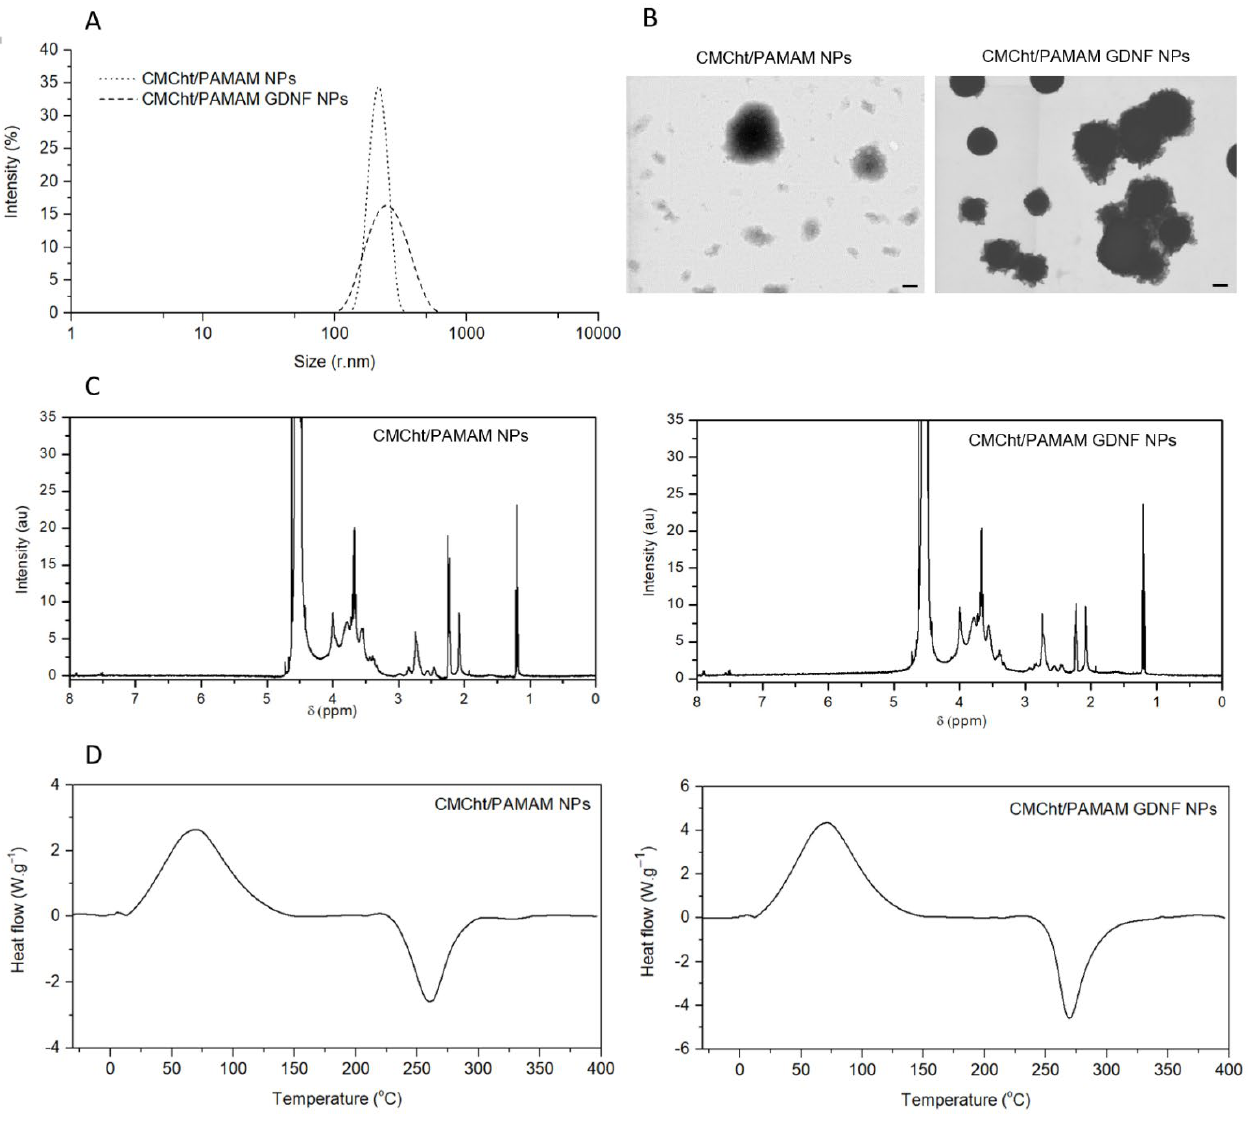
Figure 2. Characterization of CMCht/PAMAM NPs with GDNF. ( A ) Particle size distribution. ( B ) FE-SEM images of CMCht/PAMAM NPs without ( left ) and with ( right ) GDNF. Scale-bar = 100 nm. ( C ) H 1 NMR spectra of CMCht/PAMAM NPs without ( left ) and with ( right ) GDNF. ( D ) Differential scanning calorimetry spectrum of CMCht/PAMAM NPs without ( left ) and with ( right ) GDNF.